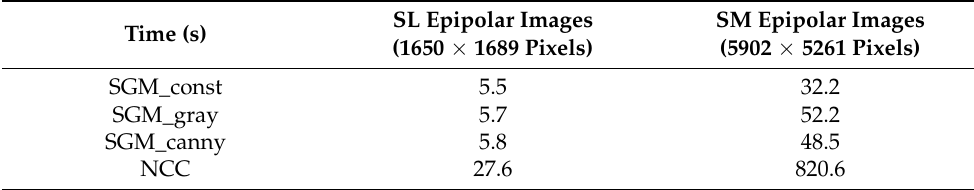
Table 10. Matching processing time of all stereo matching algorithms used in this study. Time (s)